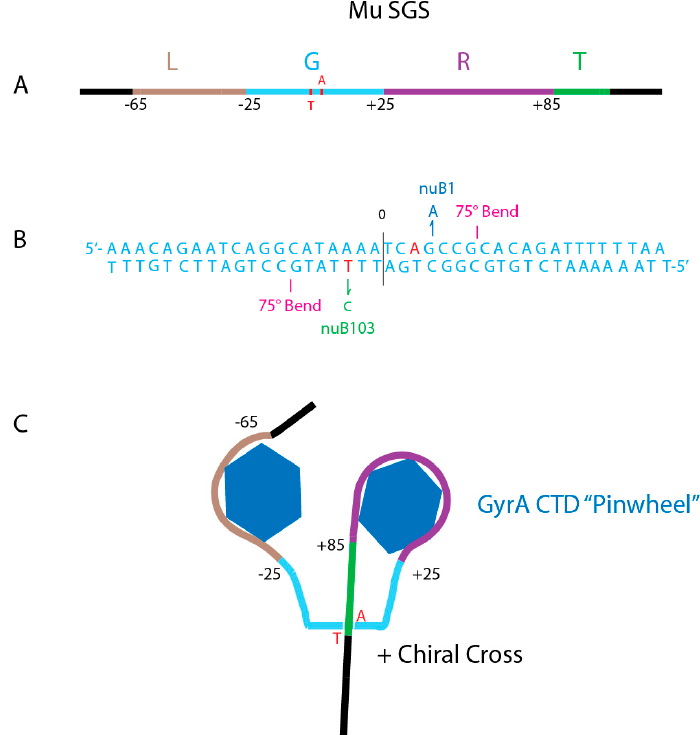
Figure 7. Anatomy of the Mu SGS. ( A ) Map of the 150 bp Mu SGS. Four regions include the left arm (Brown L), the Gate segment (Aqua G), the right arm (Purple R) and Transfer segment (Green T). Numbers show bp positions to the left ( − ) or to the right (+) of the center DNA cleavage. ( B ) The Gate DNA nucleotide sequence shows important positions for catalytic supercoiling. GyrA Tyr-122 makes a transient covalent bond with +3 A on the top strand and with − 3 T on the bottom strand (red). Mutations that enhance supercoiling processivity include the +3 G-A transition (Blue nuB1) on top, and the nuB103 − 3 T to C transition (Green) on the bottom strand. Two 75° bends occur at positions +7G, +8C on top and at − 7G, − 8G on the bottom strand [74]. ( C ) Two CTD pinwheel elements of a GyrA dimer interact with L and R arms to make a (+1) loop that places the T segment in position to pass through an open gate during a sign inversion strand transfer [75].